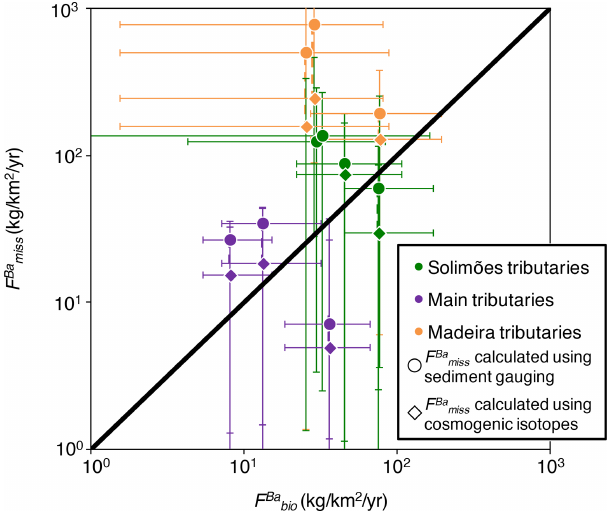
Figure 8. Flux of Ba biological uptake ( F Ba ing Ba flux as quantified from the river-scale mass budget ( F Ba Eq. 14) in the Amazon Basin. Uncertainties have been propagated using a combination of Monte Carlo simulation and Gaussian error